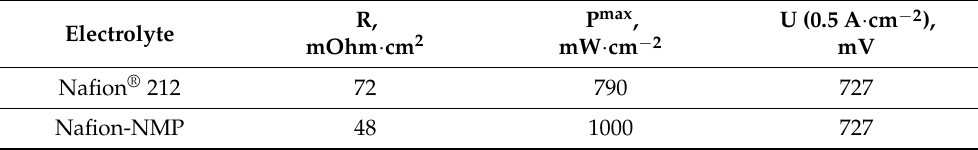
Figure 5. Voltammetry curves and power density dependence on current density for MEAs (RH = 100%, t = 65 ◦ C). Table 3. Performance of MEAs at RH = 100%, t = 65 ◦ C: R is a high-frequency resistance, P max is